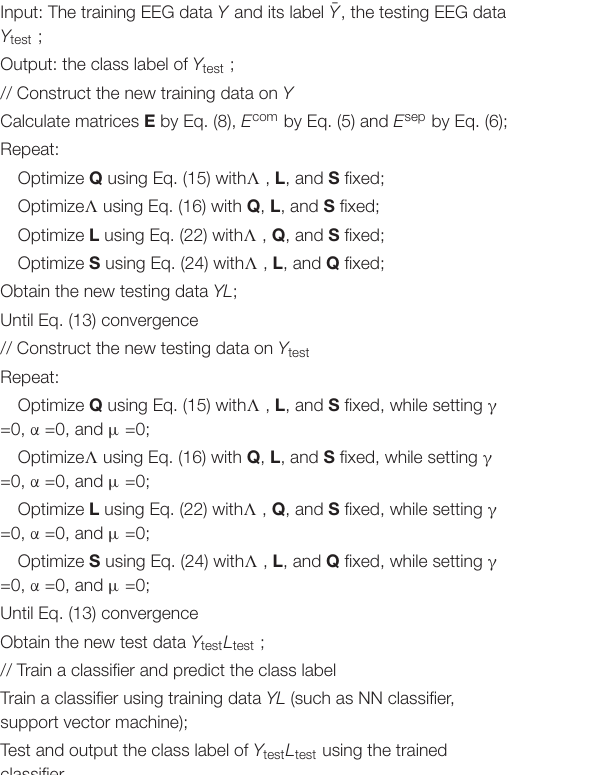
Algorithm 1: DSLRR algorithm for EEG data